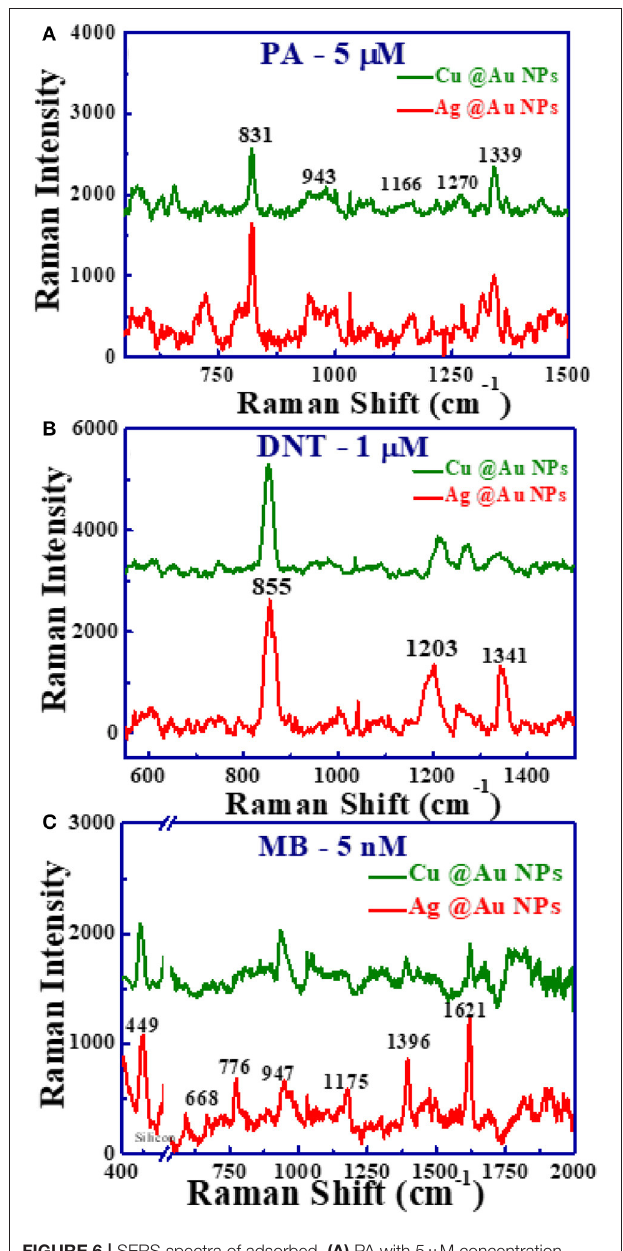
FIGURE 6 | SERS spectra of adsorbed. (A) PA with 5 µ M concentration. (B) DNT in methanol with 1 µ M concentration. (C) MB (5nM) recorded from Ag@Au NPs (red) and Cu@Au NPs (green) films with a portable Raman spectrometer operated at 785nm while the integration time was ∼ 5s. In (C) X-axis break has been used to avoid the strong Si peak at 520 cm − 1 .